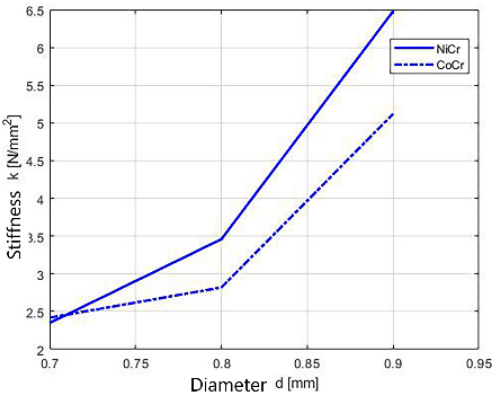
Figure 13. Stiffness dynamics of orthodontic wires.